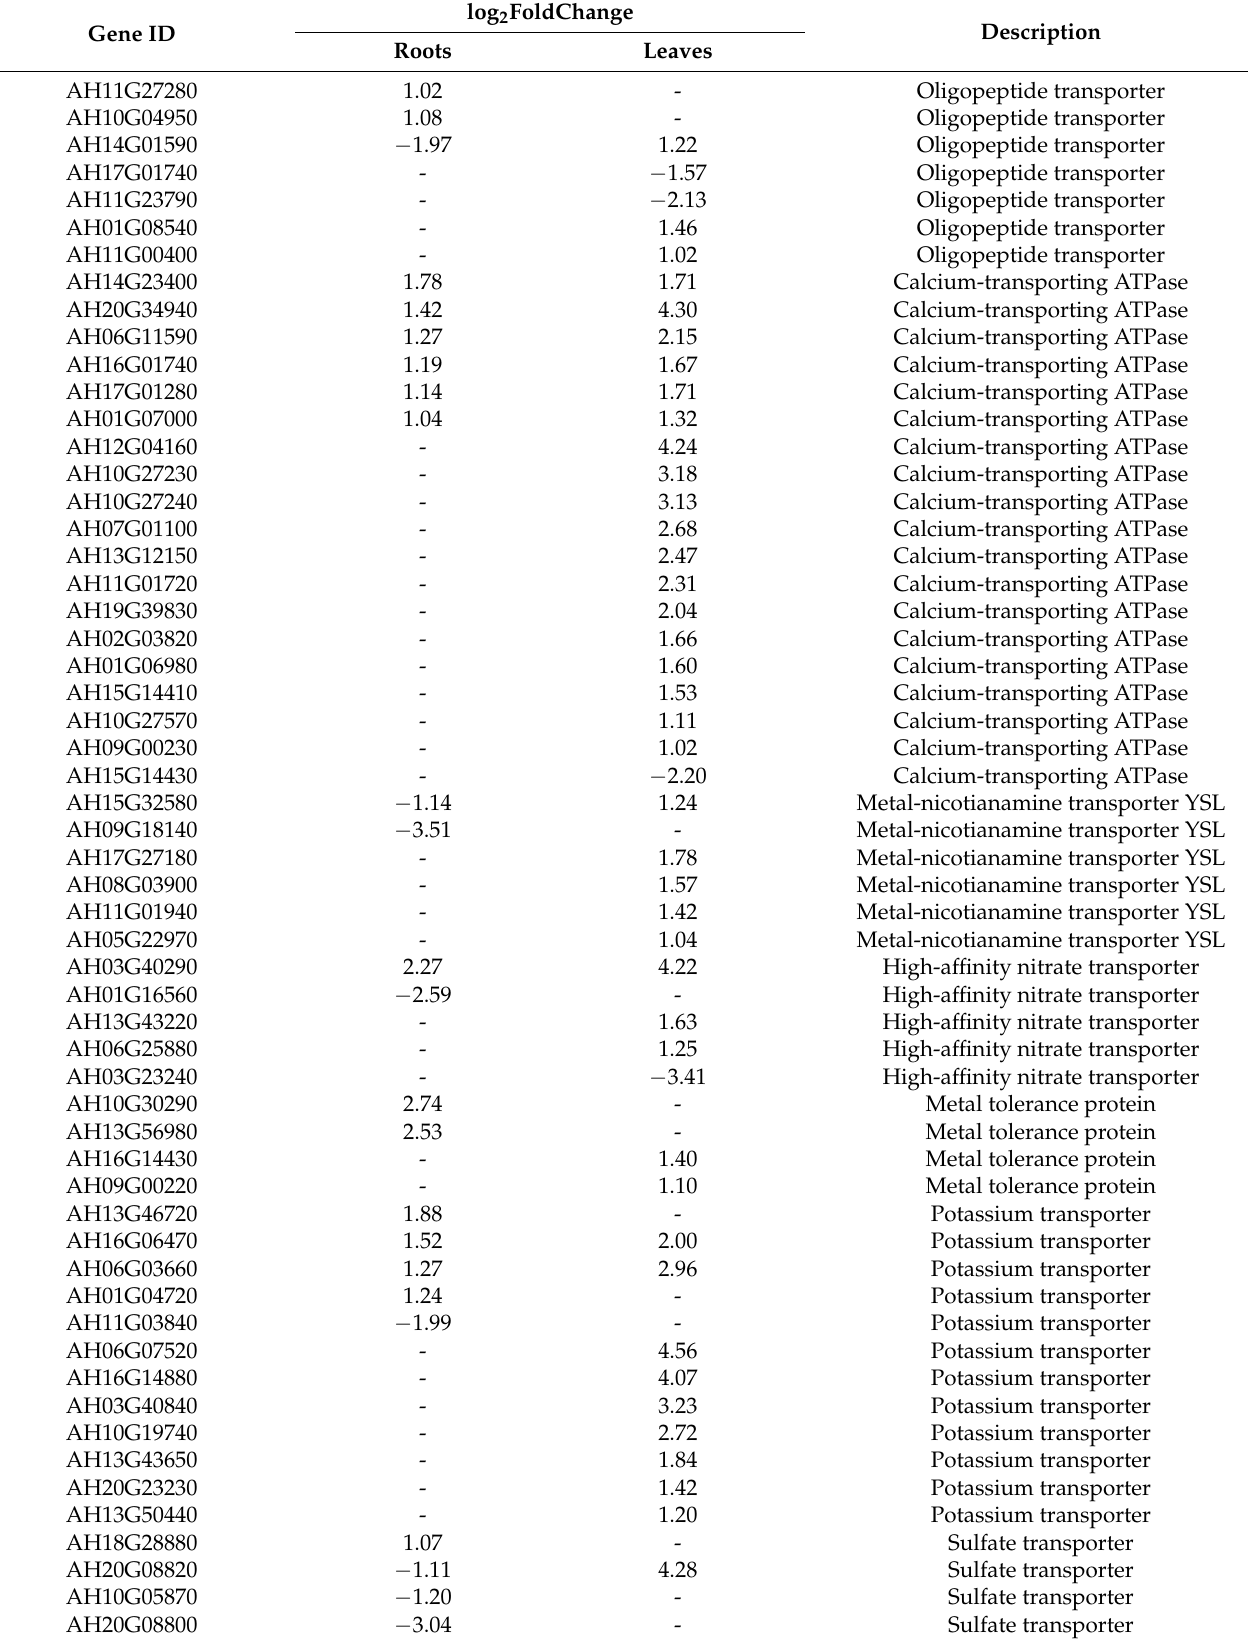
Table 5. Identification of DEGs that act as conduits and